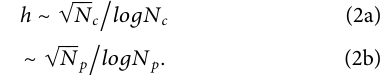
FIGURE 6 Finite size ( N c ) scaling analysis of the citation distributions of 100 individual scientists (Table 1 of Ref. [5]). The scaling fi t to the Widom – Stauffer relation (Eq. 1c) is obtained by fi tting all the data for their h -index and the N c values of total citations of the publications by individual scientists and their corresponding Kolkata index values k near the critical value k c ≃ 0.87 [5]. It turns out that the scaling form (Eq. 1c) with the exponent α =0.7 gives a good data collapse. The inset shows that the data collapse seems to get worsened by dropping the logN term in the scaling relation (Eq. 1c), although at the critical point k = k c , one gets h (cid:3) a with a =0.45±0.10,whichincludestheanalyticalprediction[4]that a =0.54inthelarge N c limit.Thecontinuouslines(inboththemain fi gure and the inset) represent the scaling functions for k < k (green) and k > k c (violet) and are drawn for a guide to the